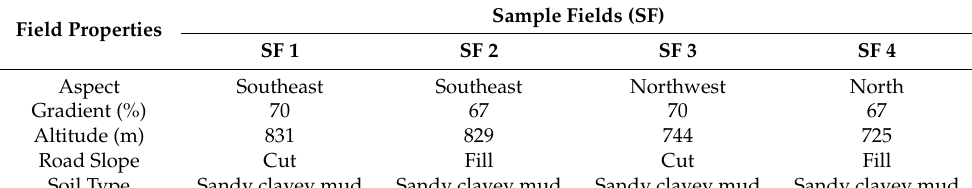
Table 1. General information related to the study area.